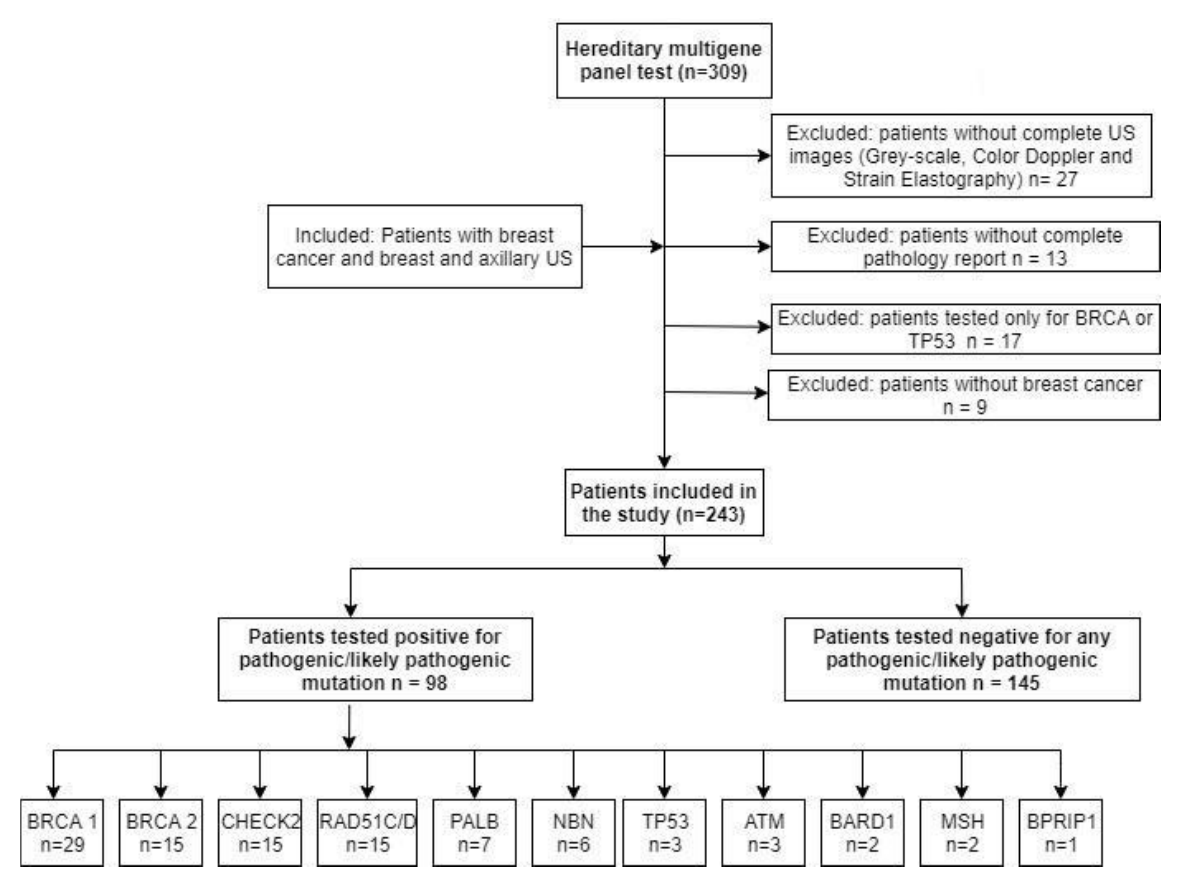
Figure 1. Study population—inclusion and exclusion